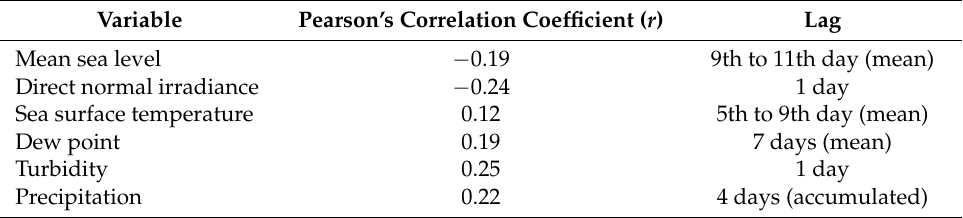
Table 1. Pearson’s correlation coefficient to identify significant lags in enterococci concentrations in surface waters at Escambron Beach with respect to the environmental parameters: Mean sea level (MSL), direct normal irradiance (DNI), sea surface temperature (SST), dew point, turbidity, and precipitation. Values are considered significant at α < 0.05.